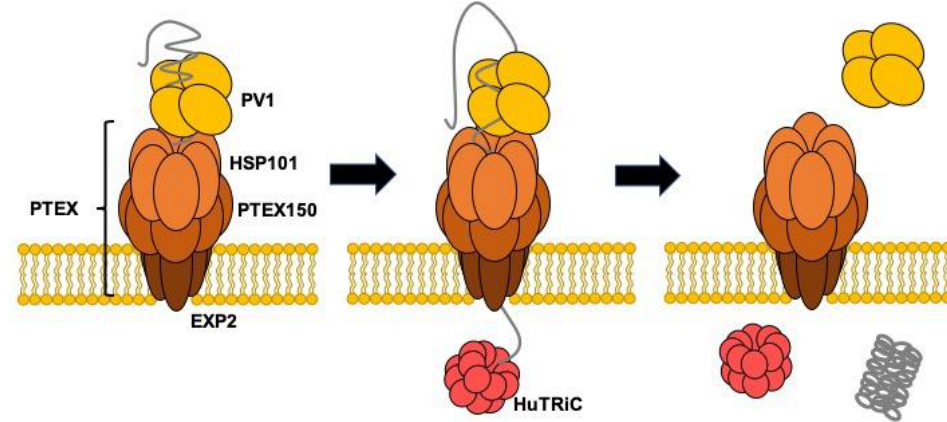
Figure 8. Schematic model for the role of PV1 in the protein transport by PTEX.